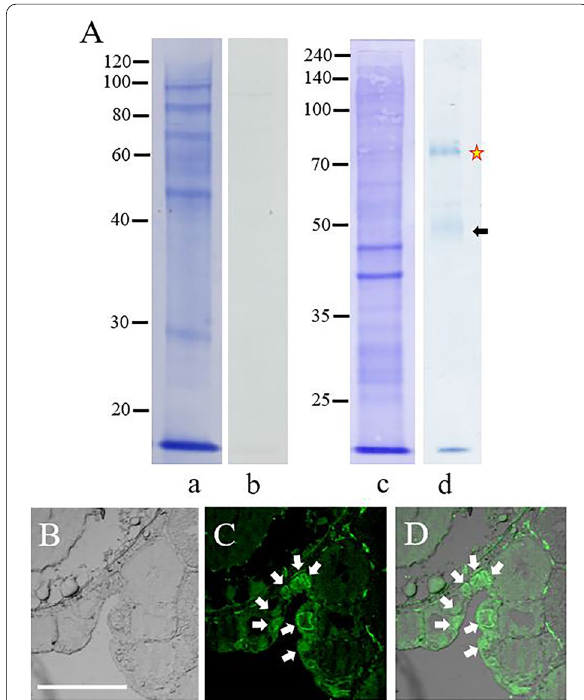
Fig. 7 Detection and localization of mZPC5 proteins in chg.l -/- females. A : SDS-PAGE and western blot assays of the liver (7Aa and 7Ab) and ovary extracts (7Ac and 7Ad) using anti-mZPC5 antibody. 7Aa: the 10% SDS-PAGE pattern of proteins in the liver extracts stained with CBB. Ab: proteins immunoreactive to the anti-mZPC5 antibody in the liver extracts. Ac: 8% SDS-PAGE pattern of proteins in the ovary extract stained with CBB. Ad: proteins immunoreactive to the anti-mZPC5 antibodies in the ovary extracts. B – D : confocal microscope observations of the same ovarian oocytes (ovarian stage less than V) to identify the locations of immunoreactive proteins in the ovarian oocytes using anti-mZPC5 antibodies as probes. B: a transmitted light image provided to illustrate the exact morphology of the ovarian oocytes without immunochemical staining. C: same as B but including the localized anti-mZPC5-immunoreactive proteins. D : overlaid images B and C. Symbols: yellow star and black arrow in Ad – immunoreactive proteins with 72–72 kDa and 50 kDa molecular masses, respectively; white arrows in C and D – oocytes that were immunoreactive to anti-mZPC5 antibodies. Scale bar in Panel B 100 =